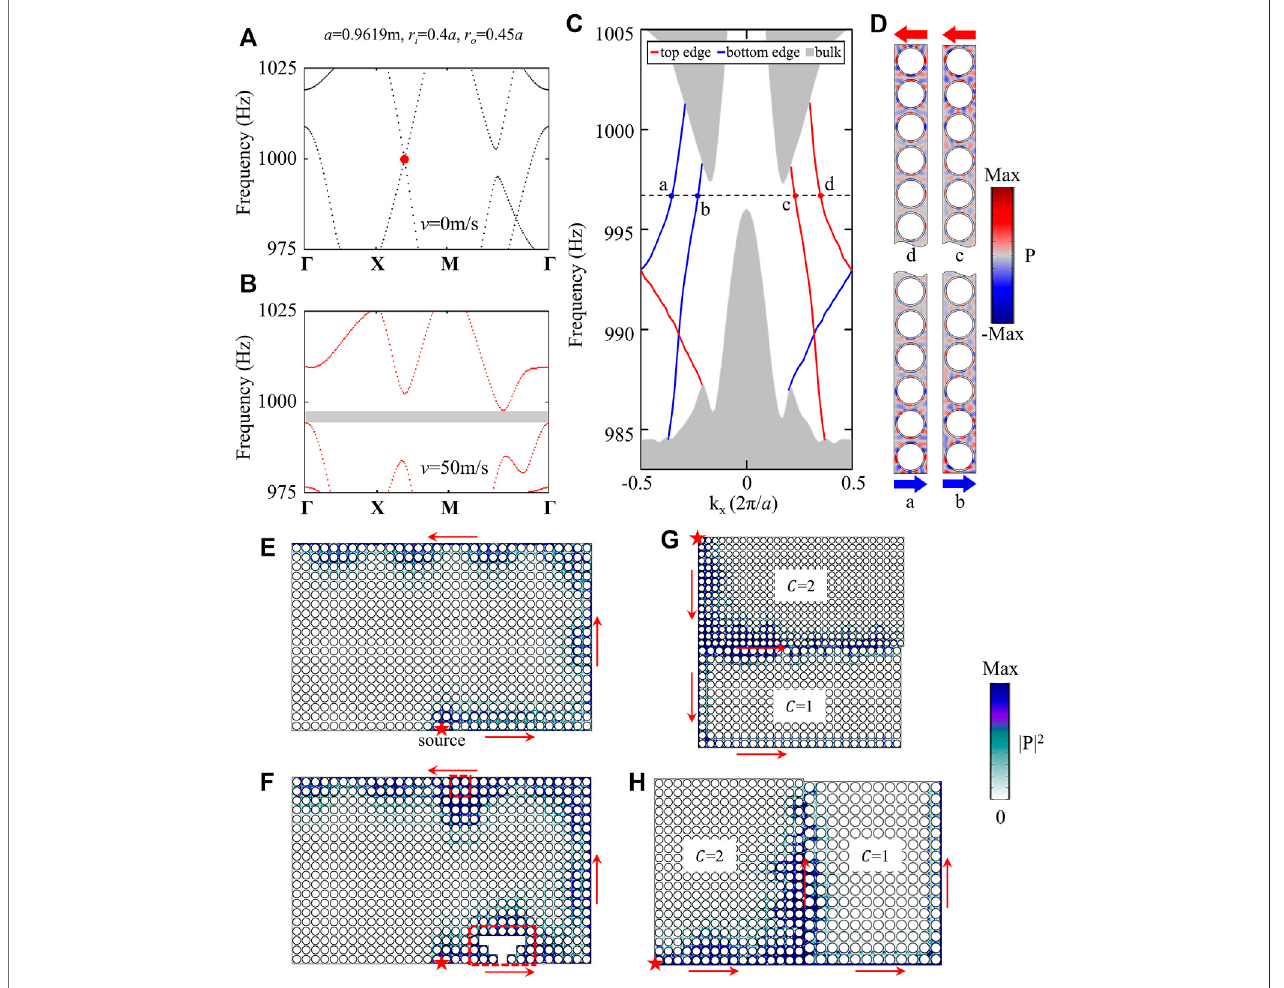
FIGURE 2 | Band structures and one-way edge modes in SC2 with C (cid:2) 2. SC2 has the same design as SC1, only that the geometric parameters are slightly changed (as listed in the fi gure). (A,B) Bulk band structures of the SC2 with and without air fl ow. The red circle marks a Dirac point on the XM line. The grey region indicates the band gap for SC2, ranging from 994.25 to 997.5 Hz. (C) Projected band structure of a ribbon supercell of SC2 enclosed in the lower and upper directions by rigid boundaries. (D) Mode pro fi les for the eigen-states marked in (C) at 996.7 Hz. (E) The intensity fi eld distributions of the one-way edge modes for C (cid:2) 2 excited at 996.7 Hz. (F) The same as (E) , only with local perturbations. (G,H) Edge modes propagation in structures joined by SC1 with C (cid:2) 1 and SC2 with C (cid:2)